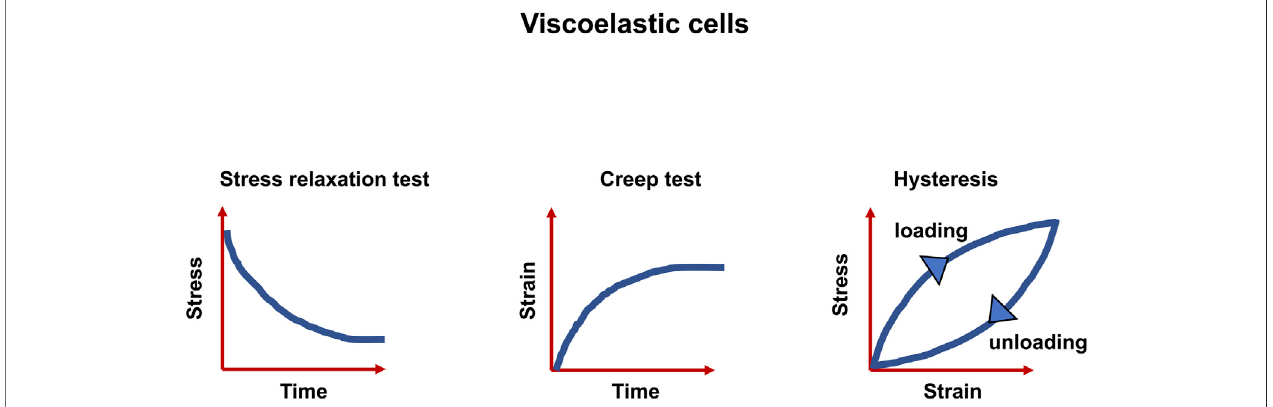
FIGURE1| Viscoelasticmatterarecharacterizedbythreefeatures,therelaxationofstress,theresponsetocreeptestandthehysteresisbetweenstressandstrain.